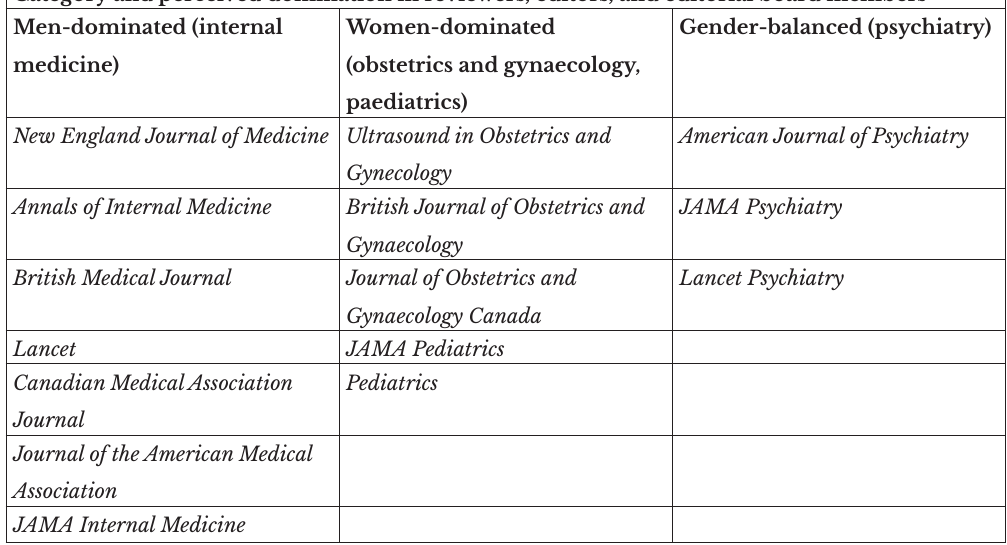
Table 1. Fifteen journals selected for the study of gender disparity in their reviewers, editors, and editorial board